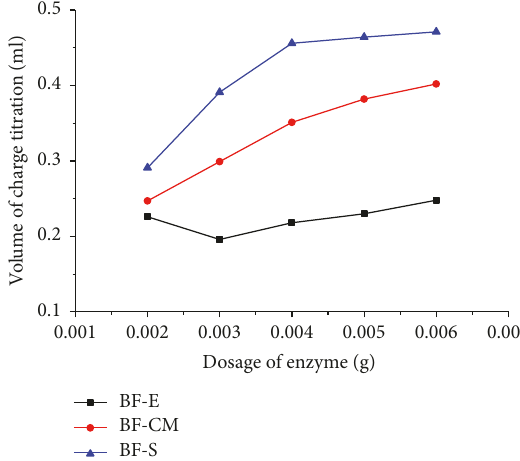
Figure 4: Effect of treatments on the surface